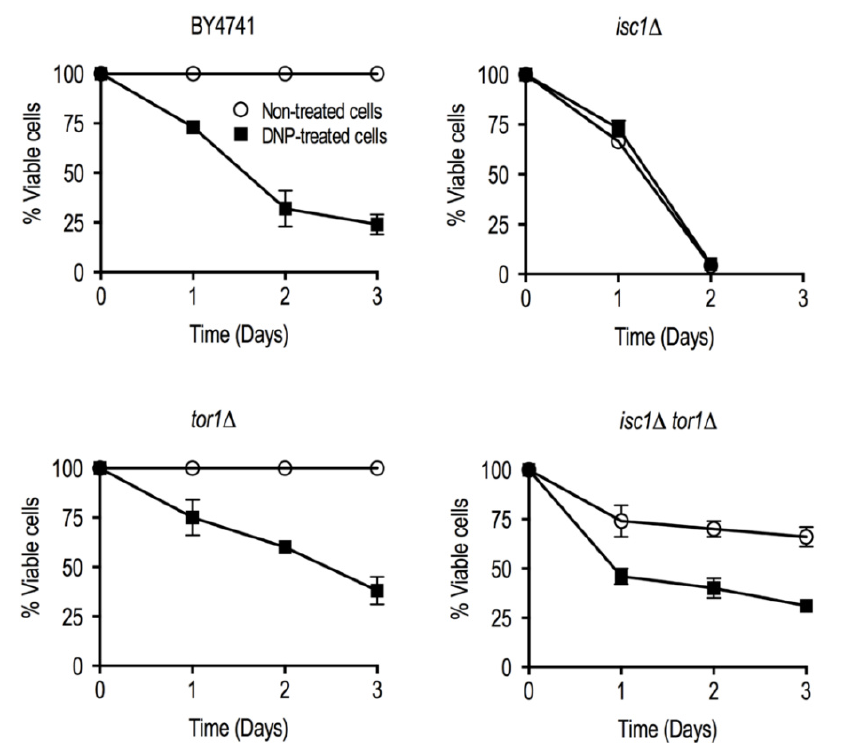
FIGURE 3: Increased mitochondrial coupled respiration imparted by reduced TORC1 signaling extends lifespan in isc1 Δ cells. S. cerevisiae BY4741, isc1 Δ , tor1 Δ and isc1 Δ tor1 Δ cells were grown in SC-medium to the PDS phase, treated with 10 µM 2,4-dinitrophenol (DNP; (cid:1) ) or vehicle (DMSO;  ) and kept in the medium at 26°C. The viability was determined by standard dilution plate counts and expressed as the percentage of the colony-forming units at time T in relation to T 0 . Values are mean ± SD of at least three independent exper-